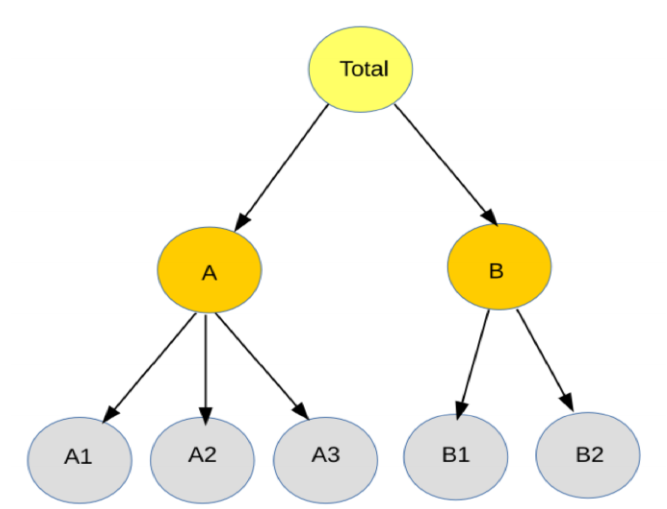
Figure 1. Two-level hierarchical time series